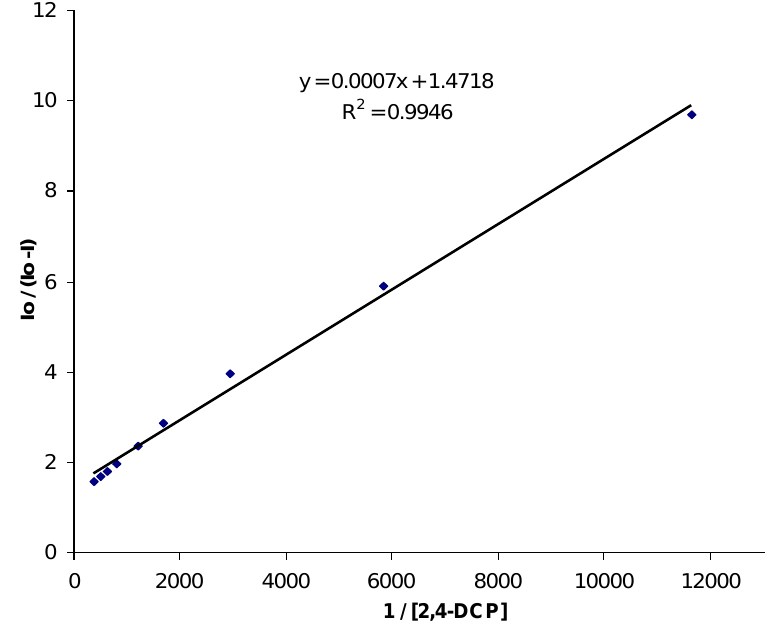
y = 0.0007x + 1.4718 R 2 =